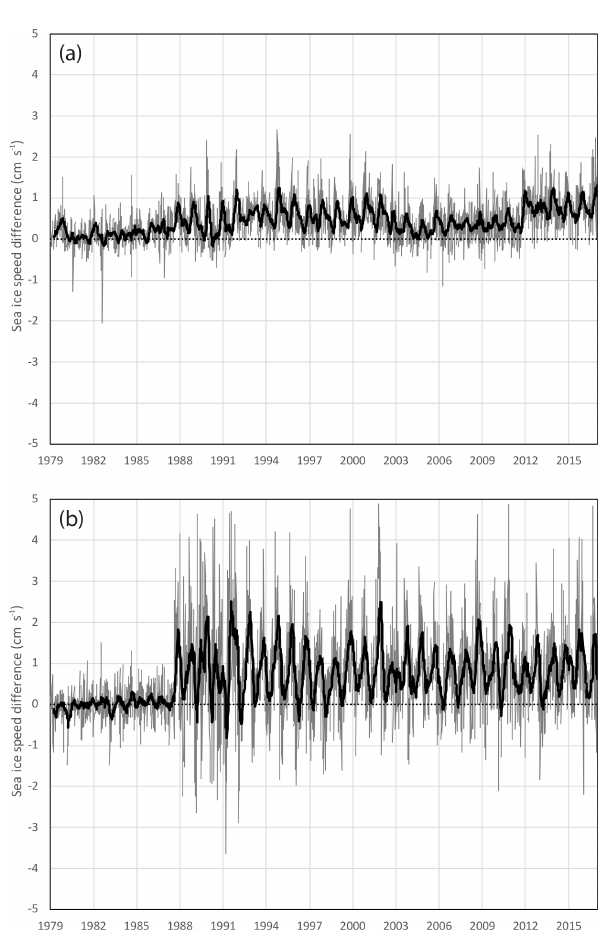
Figure 7. Arctic weekly average sea ice drift speed difference be- tween Version 4 and Version 3 (V4–V3), 1979–2017. A 13-week running average is overlaid on the weekly values to highlight sea- sonal variability. The weekly average value is derived by averaging all vectors in the weekly motion